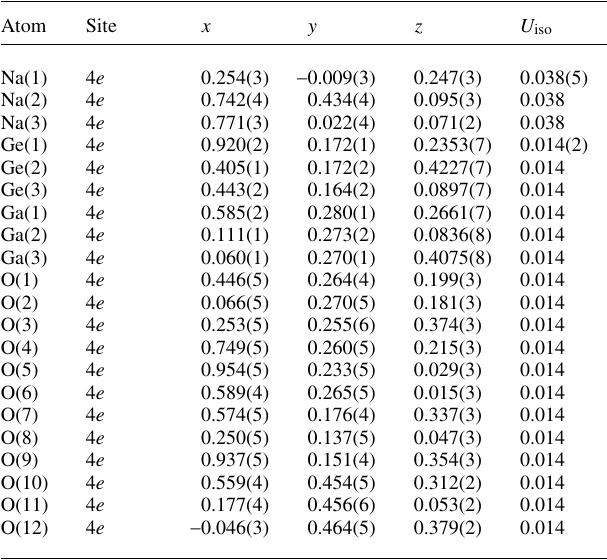
Table 2. Atomic coordinates and displacement parameters (in Å 2 )